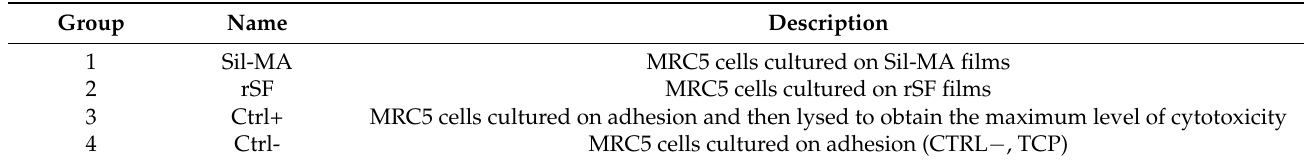
Table 4. Groups used in the LDH